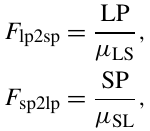
Figure 1. Scheme of the DPPS model. The model includes two dynamic P pools, i.e. the labile pool (LP) and the stable pool (SP), comprising both organic and inorganic P. Five inputs of P to the system are defined: mineral fertilizer and manure, weathering, deposition, fresh soil, and litter. µ LS and µ SL (years) denote the transfer time of P from LP to SP and from SP to LP, respectively. Modified from Sattari et al.